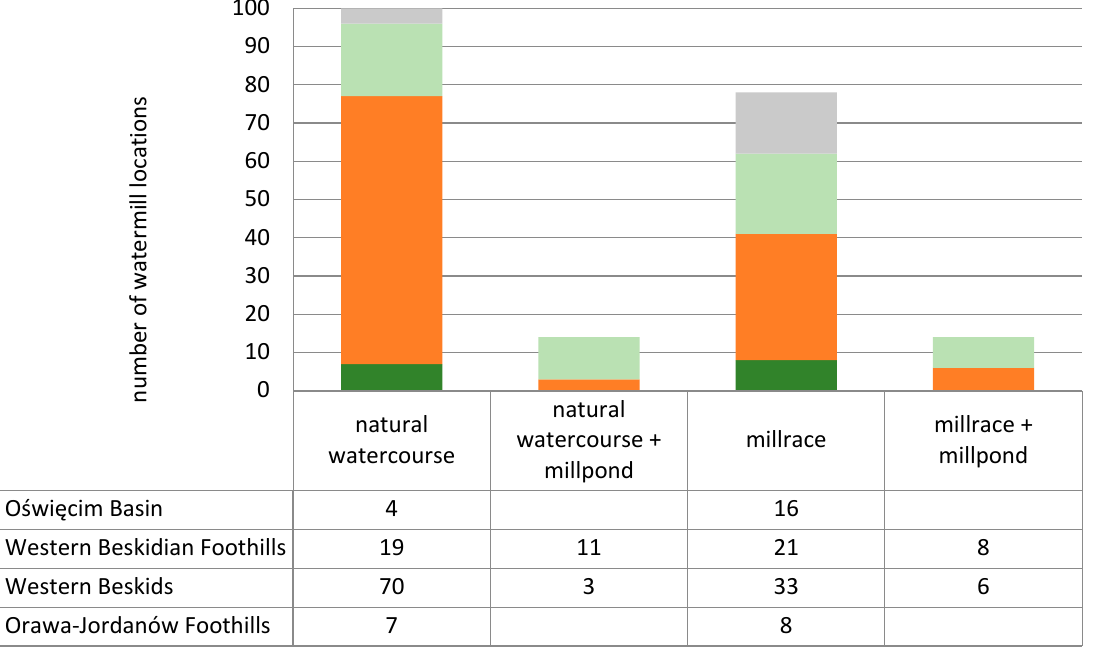
Figure 4. Water source for the watermills in the River Skawa catchment area, broken down into main physico-geographical regions.